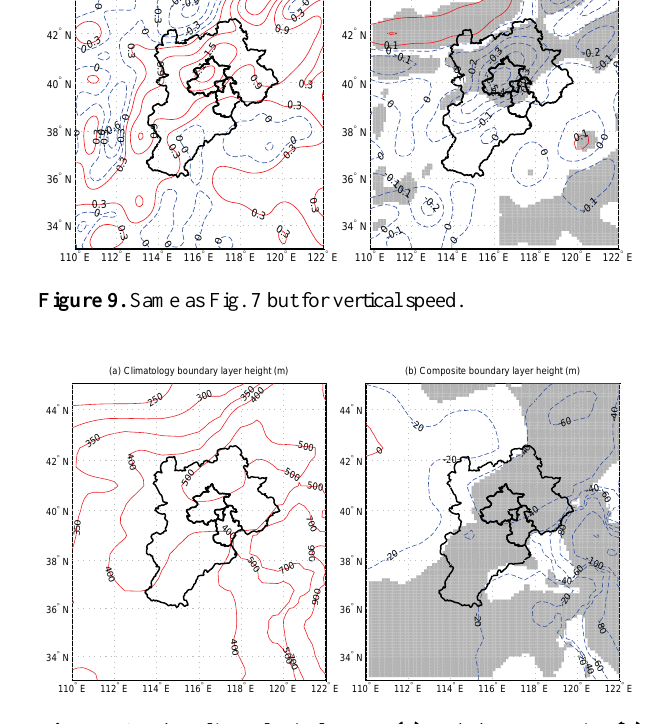
circulation conditions, such as in controlling the pollutants’ discharge.